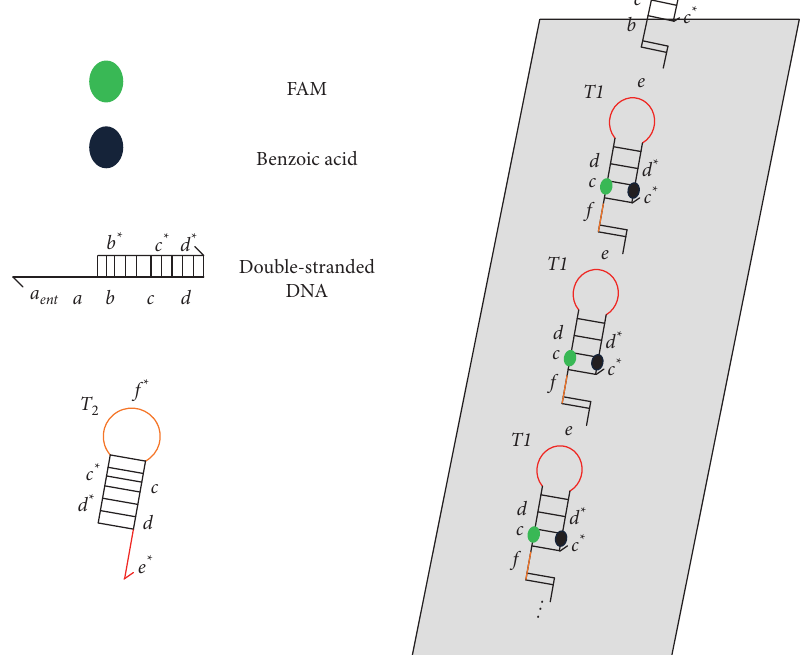
Figure 5: The case of AND gate input (0, 0).